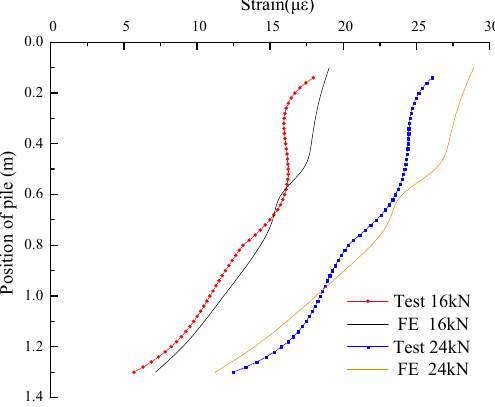
Figure 10. Comparison between the results of the test and FE.